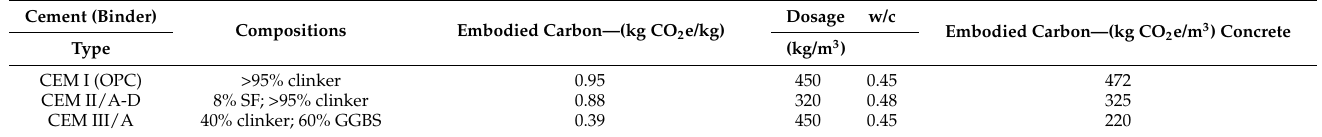
Dosage w/c Embodied Carbon—(kg CO 2 e/m 3 ) Concrete